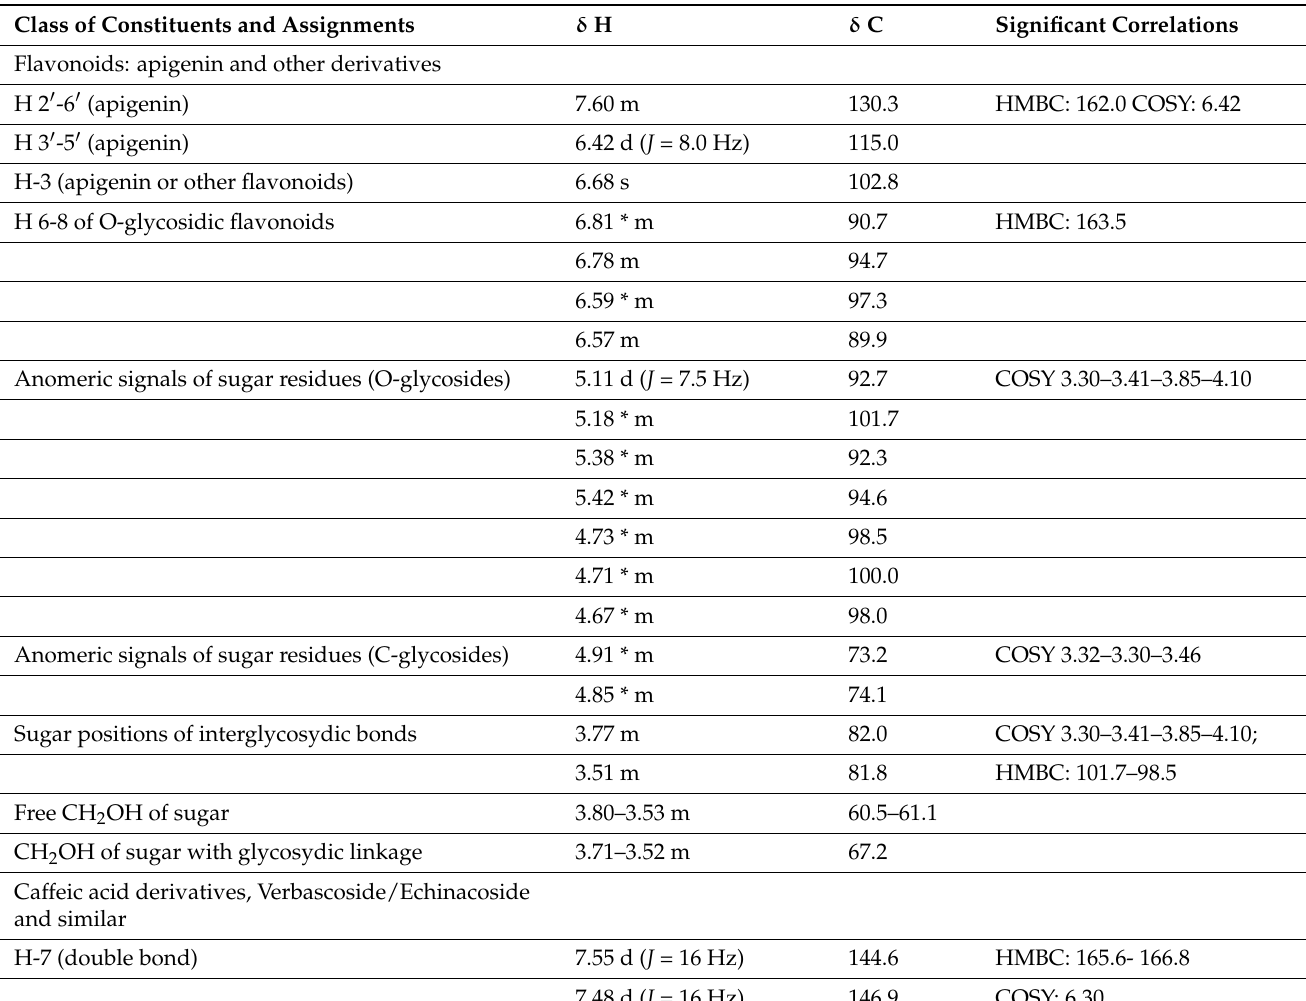
Table 1. 1D and 2D NMR correlation of the main classes of constituents of R. michauxii extract at the flowering stage. * partially overlapped